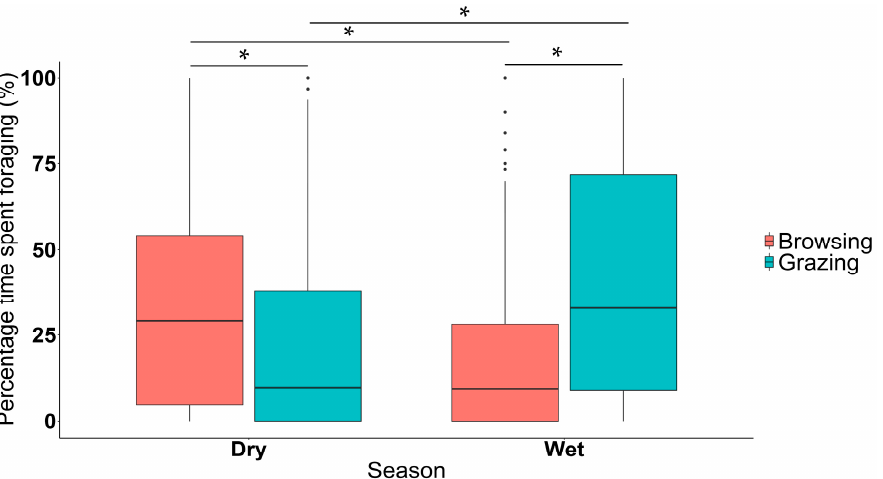
Figure 4. Boxplot depicting the percentage time spent foraging (%) (broken down into grazing and browsing) in the dry and wet season. Number of observations = 428. * Indicates statistically significant differences between groups.